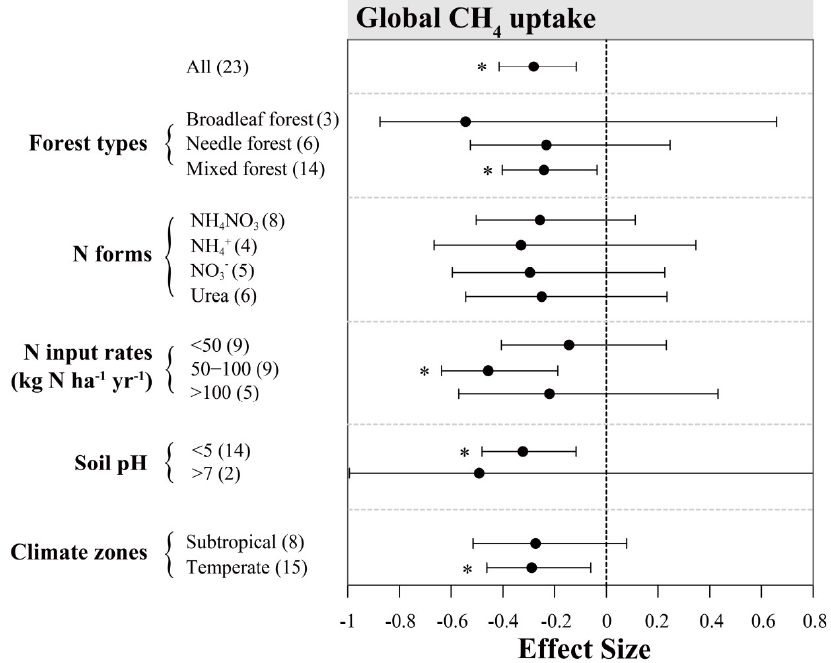
Figure A1. Effects of N inputs on forest soil N 2 O emissions outside China. Error bars represent 95% confidence intervals (CI). The vertical dashed line indicates effect size = 0. If the 95% CI does not overlap with zero, the effect of N input is considered as statistically significant and denoted by * in the figure. From top to bottom are the results of subgroups, including “forest types, N forms, N input rates (kg N ha −1 yr −1 ), N addition duration (yr), soil pH and climatic zones”. Numbers in pa- rentheses represent the sample sizes.